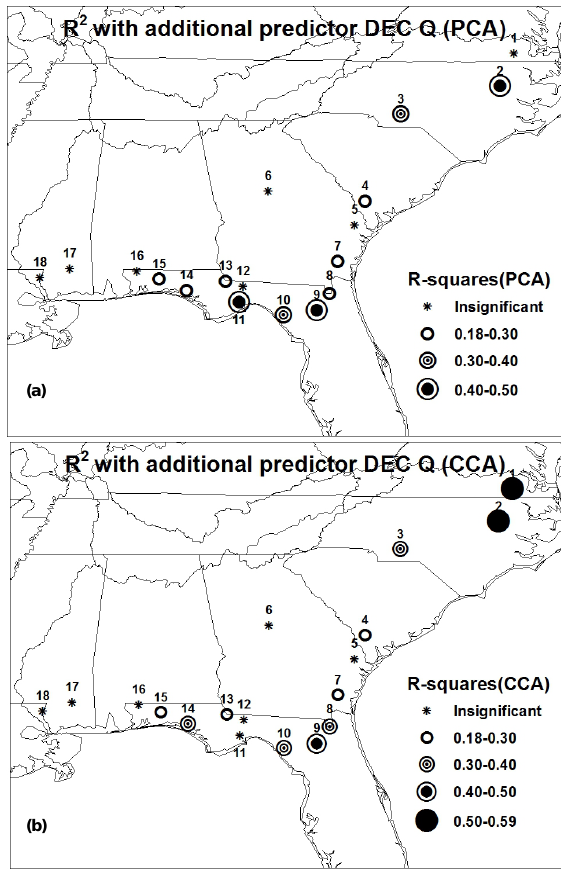
Figure 7: R 2 (based on equation (3)) of PCR(a) and CCA(b) model predicted TN loadings Fig. 7. R 2 (based on Eq. 3) of PCR (a) and CCA (b) model pre- obtained using both PC’s of forecasted precipitation and December streamflow under SSV. dicted TN loadings obtained using both PCs of forecasted precipi- tation and December streamflow under SSV.